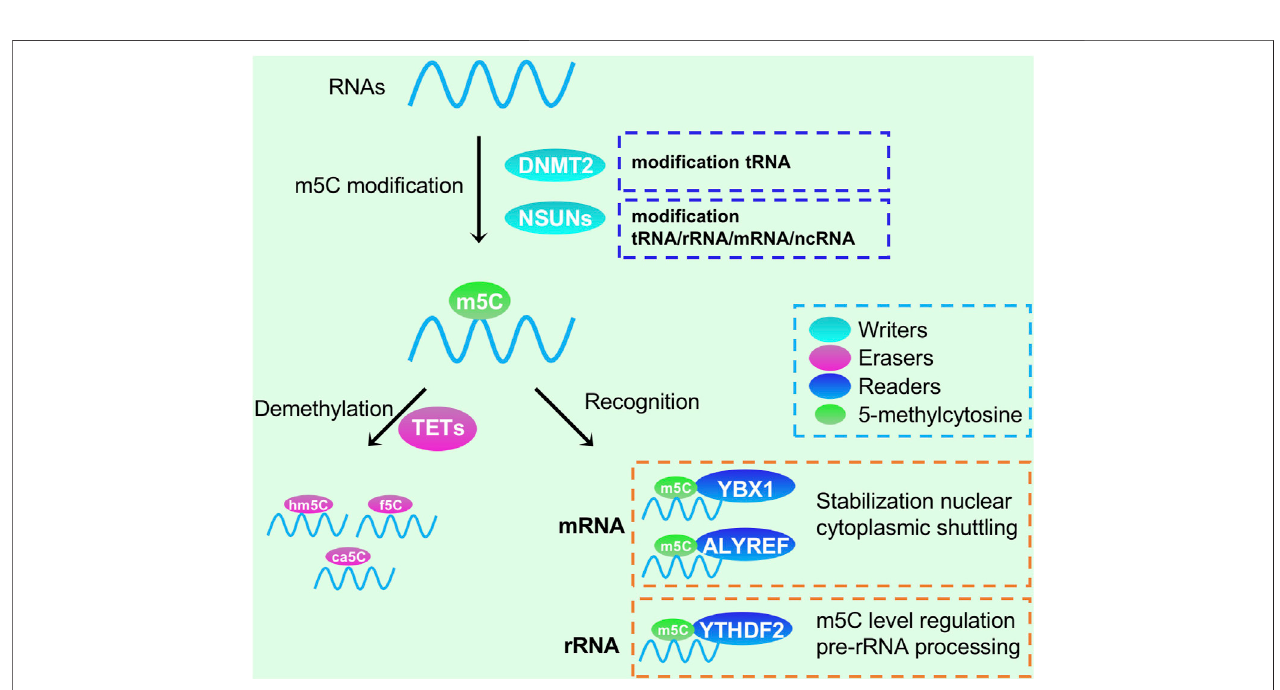
FIGURE 3 | Functions of RNA m5C modi fi cation in RNA processing and metabolism. DNMT2 and NSUNs could methylate tRNA, rRNA, mRNA and ncRNA; YTHDF1, YBX1 and ALYREF could recognize m5C modi fi cation, while TETs could demethelate them.